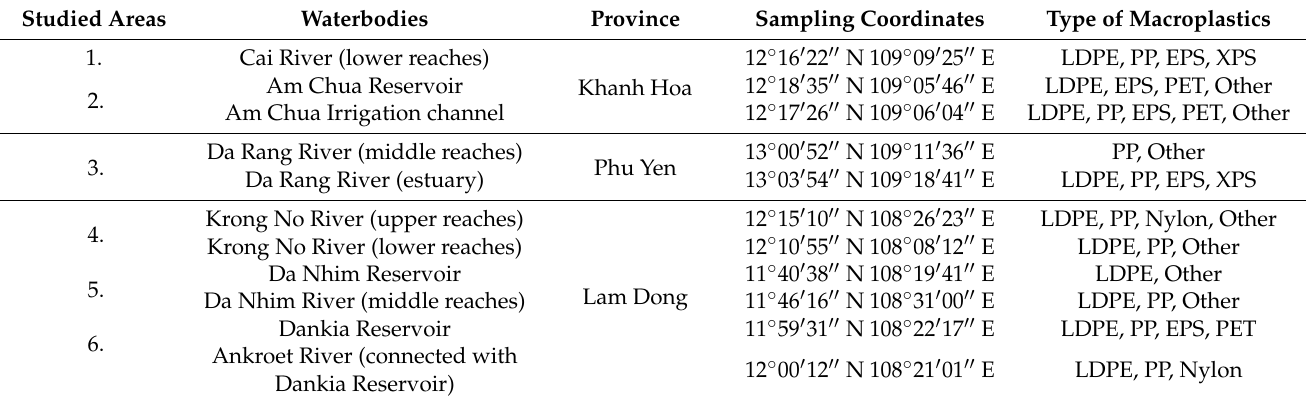
Table 1. Qualitative evaluation of macroplastics contaminations in water bodies of Central Vietnam.